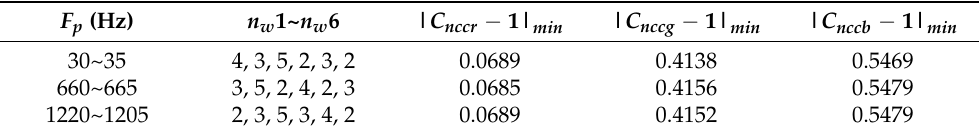
Table 3. The normalized cross-correlation when fine-tuning the peak frequency.